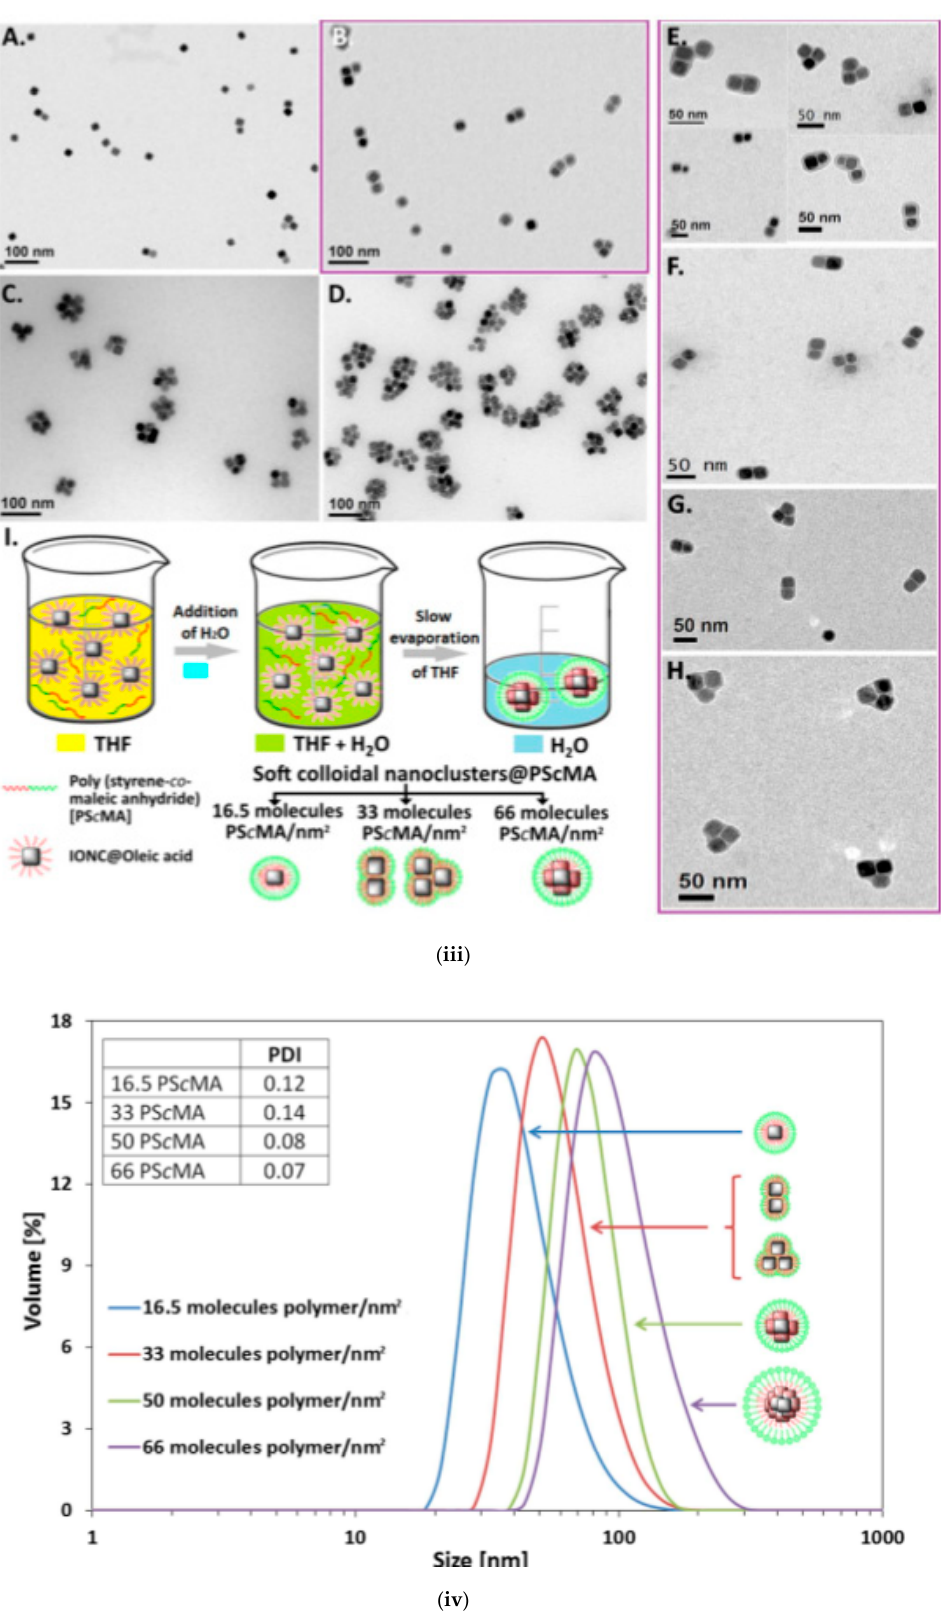
Figure 4. Controlled colloidal assembly of iron oxide nanoparticles from highly volatile ferrofluids. ( i ) ( a ) Starting from the same hydrophobic iron oxide nanocubes (IONCs) (23 ± 3 nm), IONCs are transferred in water by mixing the hydrophobic IONCs in toluene with the gallol-bearing PEG